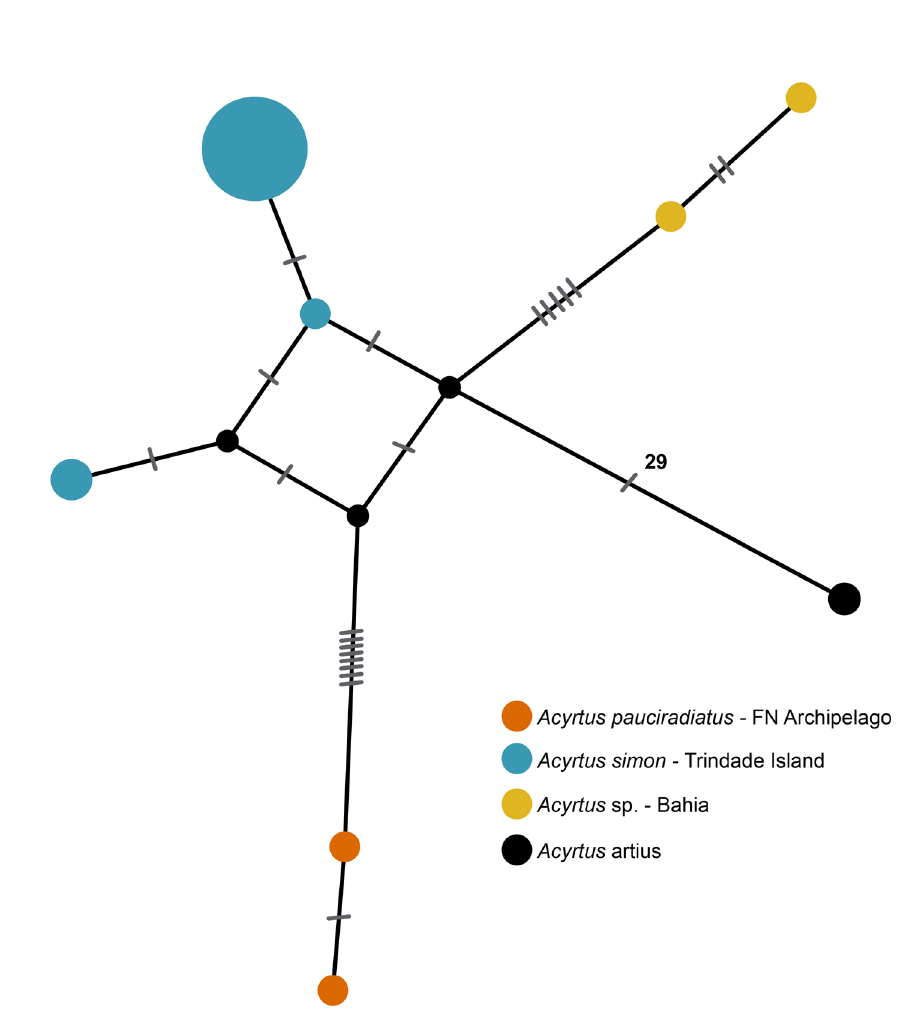
FIGURE 5 | Haplotype network of Acyrtus artius and the representatives of Acyrtus in the southwestern Atlantic. FN = Fernando de